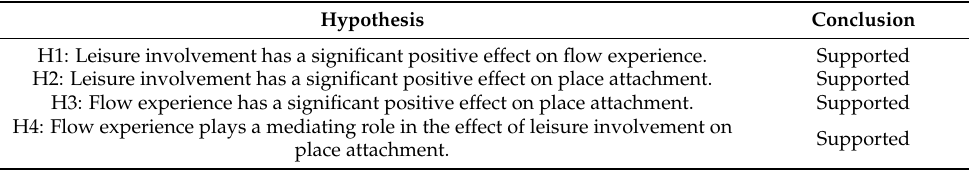
Table 7. Results of hypothesis